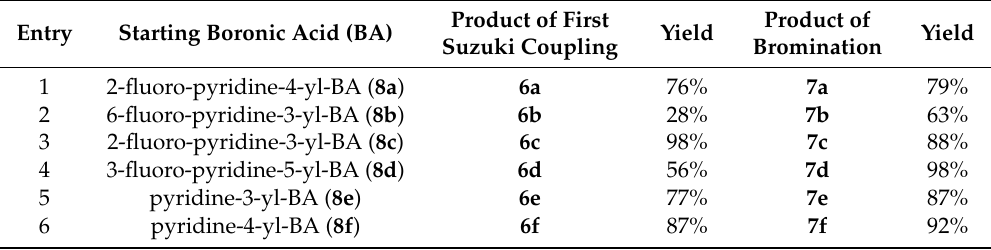
Table 1. Yields of Suzuki coupling with compound 5 (products: 6a – 6f ) and of bromination (products: 7a – 7f ).